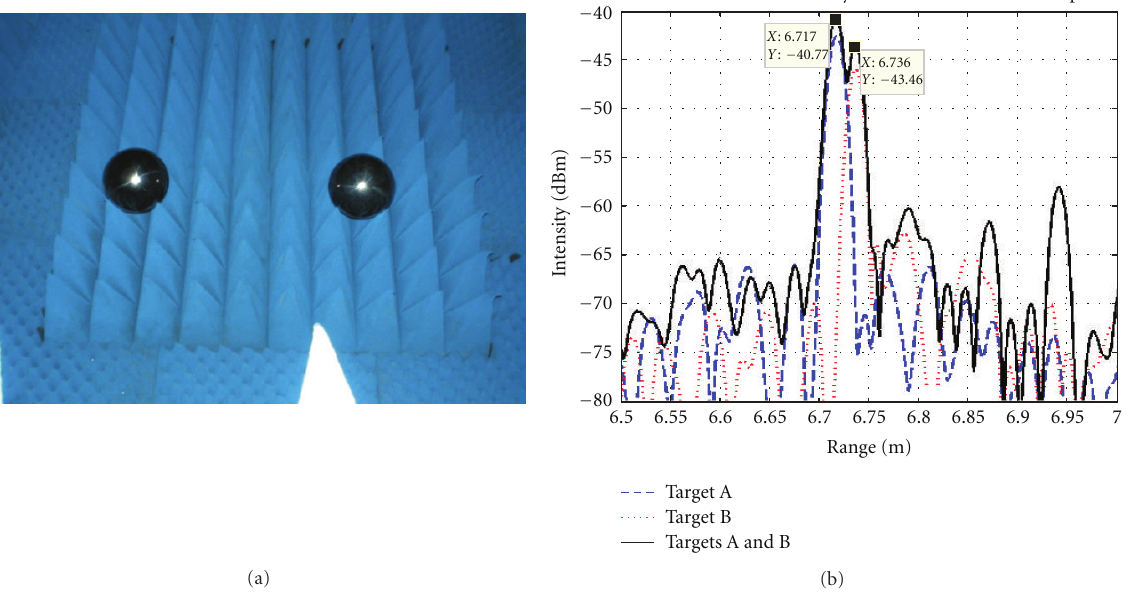
Figure 9: (a) Two 150mm spherical targets within an otherwise empty chamber. (b) Linearised results of both targets in isolation, and